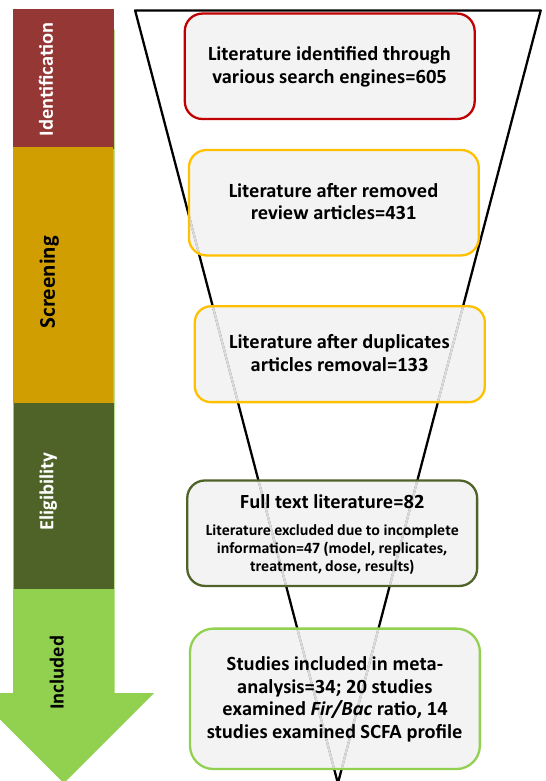
Figure 1. Meta-Analysis flow chart as per PRISM